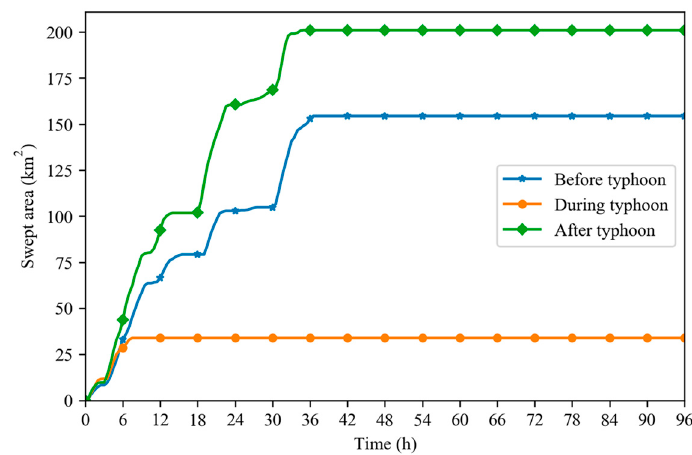
Figure 10. Time evolution of swept area (km 2 ) before, during, and after typhoon. Time is the hour after the release of the oil spill.